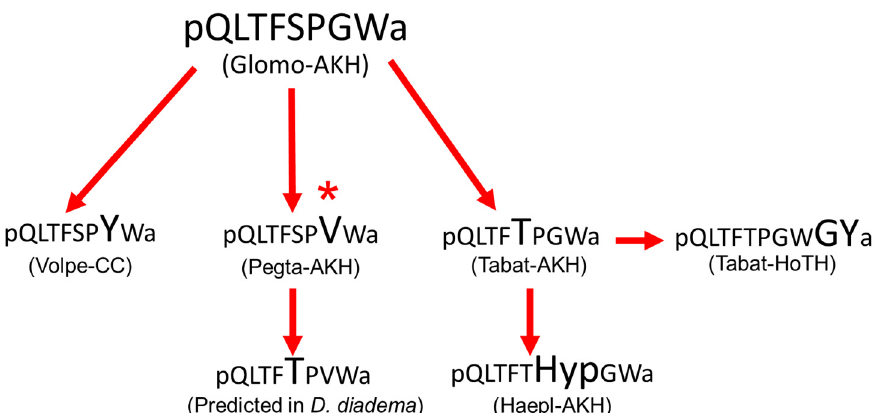
Figure 9. Hypothetical molecular evolution of adipokinetic peptides in Diptera. Glomo-AKH is assumed as ancestral peptide for this order. The amino acid substitution in each peptide is indicated in a larger font than the peptide from which it is hypothetically derived. All substitutions are point mutations except the change from Glomo-AKH to the novel Pegta-AKH. * The switch from Gly7 to Val7 requires two base changes.